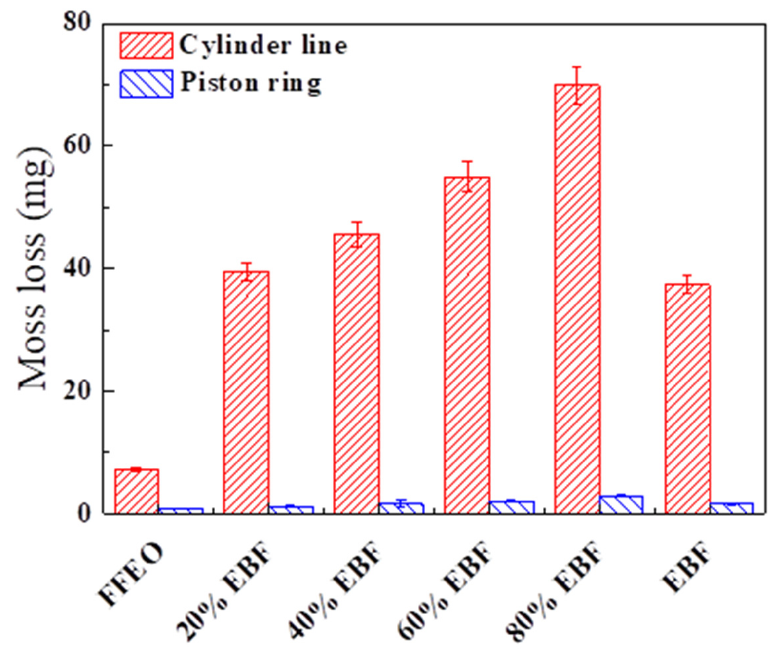
Figure 3. Variations in mass losses of the cylinder liner and piston ring with different oils.